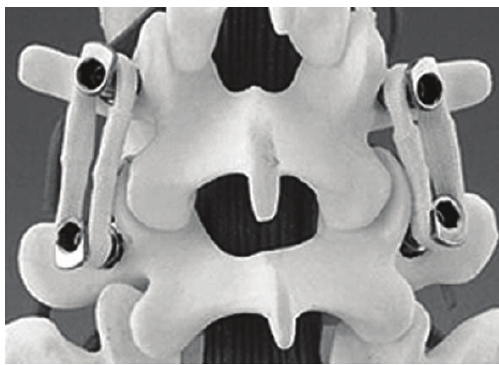
Figure 1: Graf ligamentoplasty system (left) and application on the lumbar spine